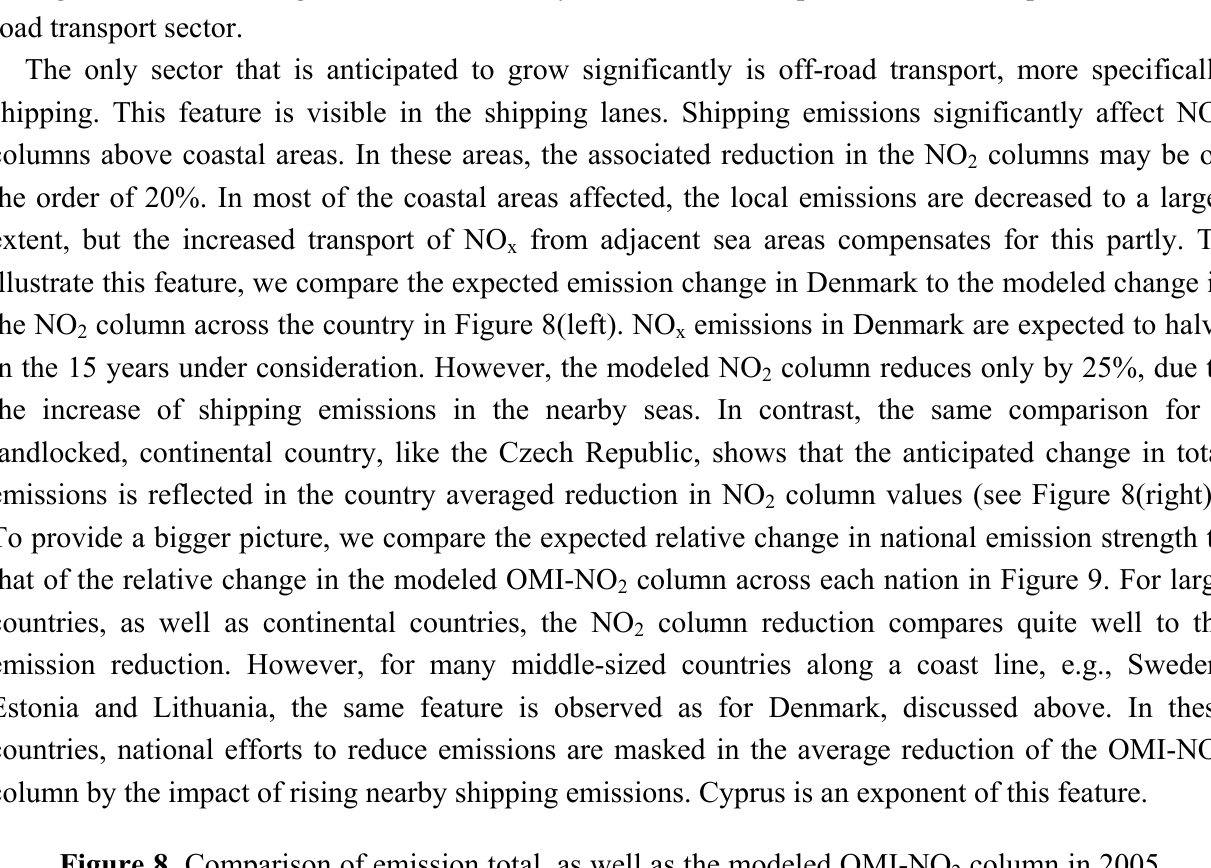
column in 2005 2